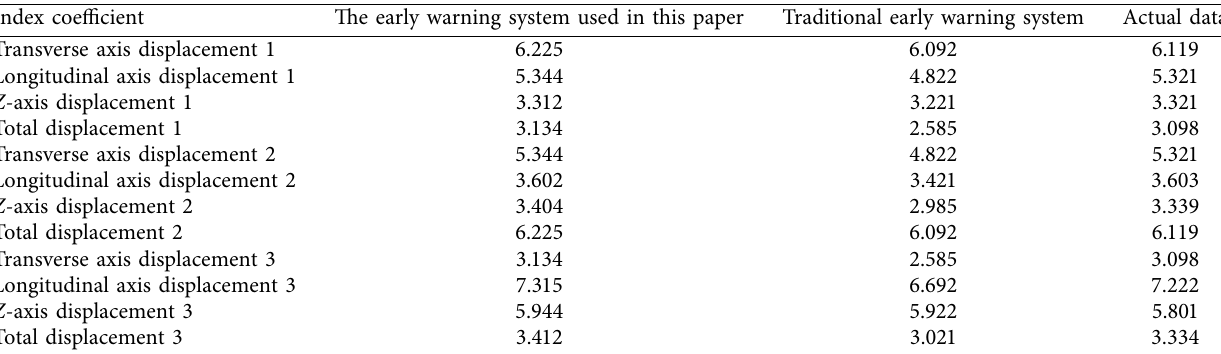
Table 5: Comparison of experimental data in area 4.